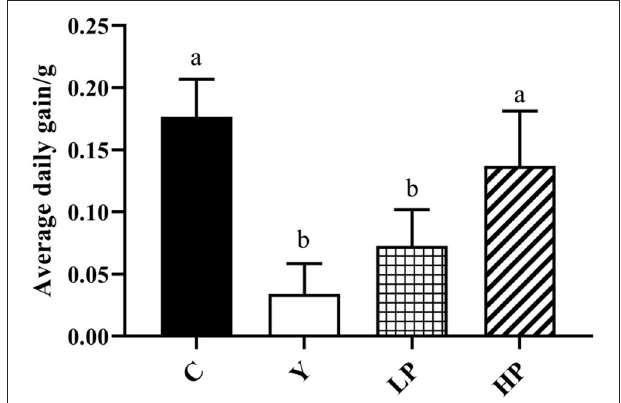
FIGURE 1 | Effects of OP on the average daily gain in oxidative injured mice. Different letters in the figure represent significant differences ( P < 0.05). C: the normal group; Y: the Cy-induced group; LP: Cy + 200 mg/kg OP; HP: Cy + 400 mg/kg